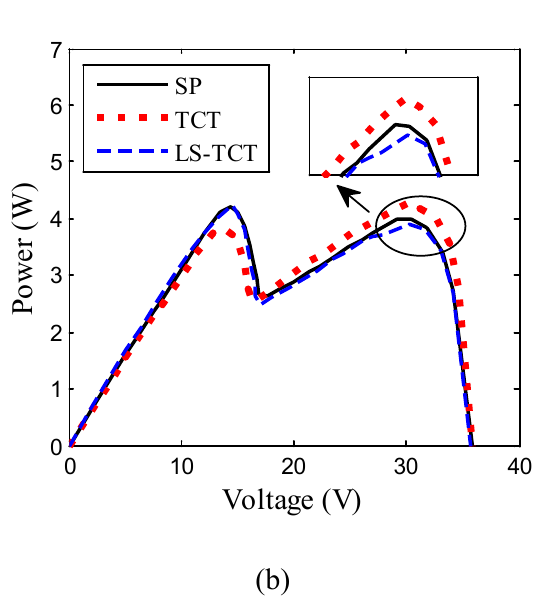
Figure 9. (a) I-V (b) P-V curves of SP, TCT and LS- TCT solar PV array under shading case-3